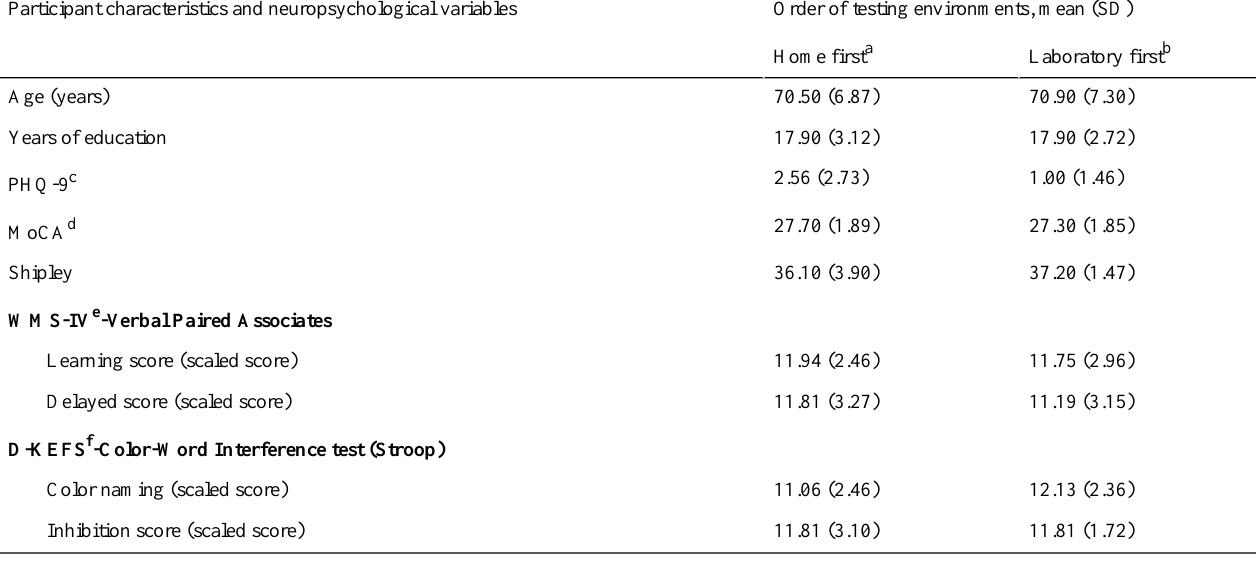
Order of testing environments, mean (SD)Participant characteristics and neuropsychological